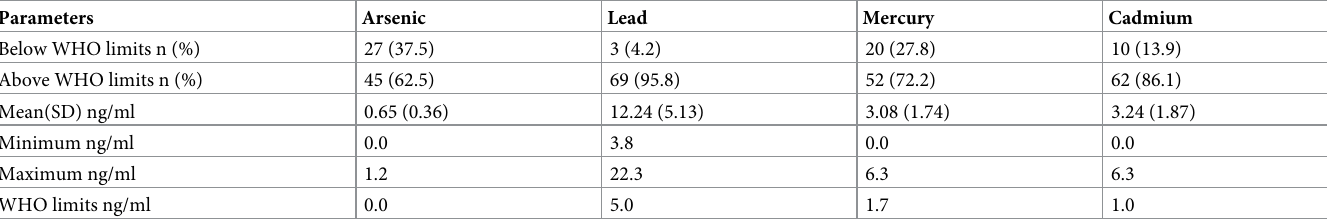
Table 3. Concentration of toxic heavy metals in the breast milk of the non-diabetic group N = 72.